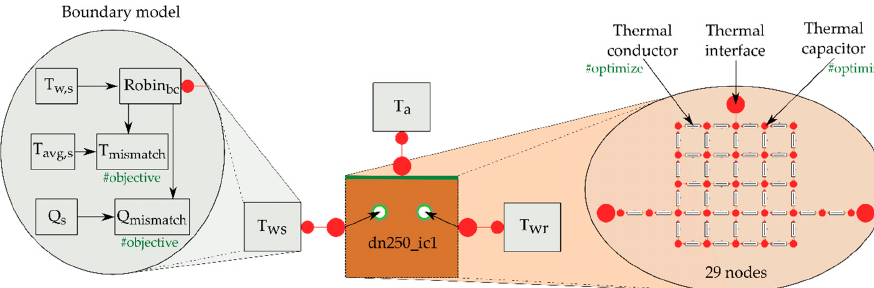
Figure 3. Model structure of the simplified physics implemented in Modelica.